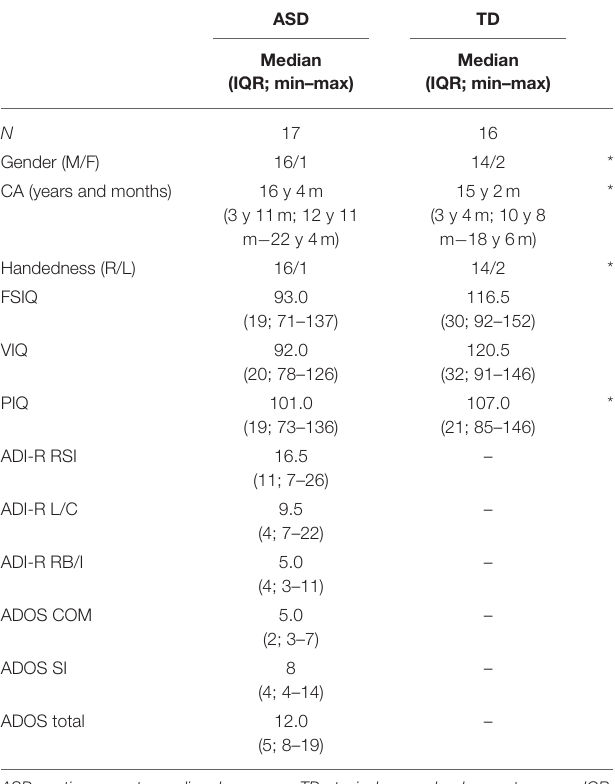
TABLE 1 | Characterization of the ASD and TD